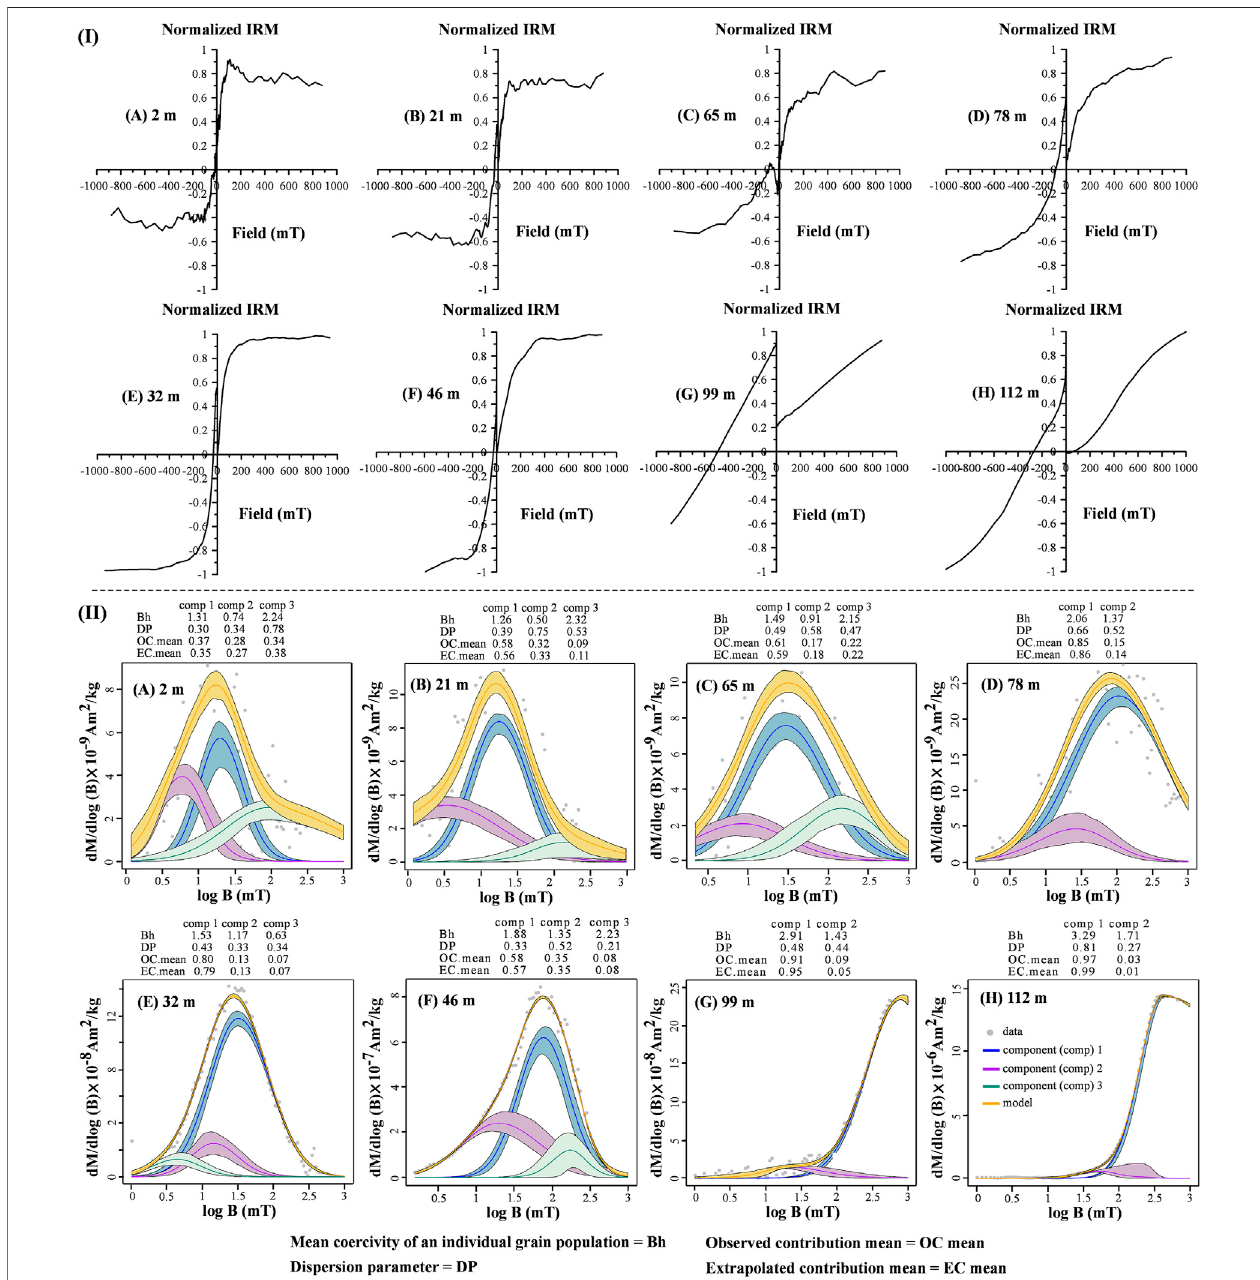
FIGURE 7| (I)Representative IRM acquisition curves and (II) IRM componentanalyses oftypical samplesat various horizons of the Palpa section. The curvesfrom sampleswith alow χ value areshown in (A – D) and ahigh χ value in (E – H) . Note thatthe coercivity distribution (gray circles) isused fromIRMacquisitionmeasurements.